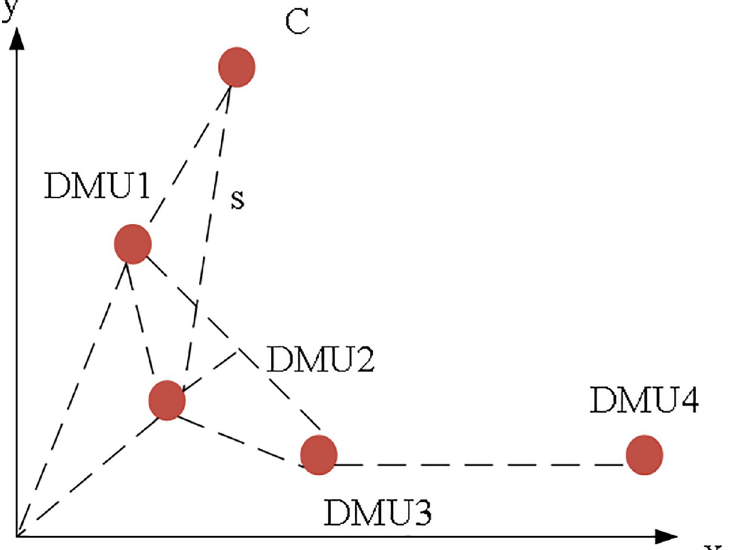
Fig 1. Structure of super efficiency